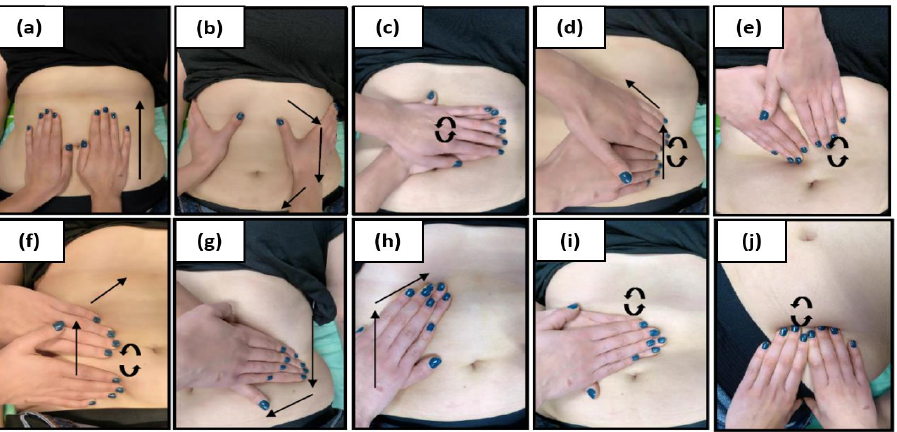
Figure 4. Manual lymphatic drainage of the abdomen; effleurage: during inhalation, rotary technique from the pubic bone to the sternum ( a ); during exhalation, rotary technique from the costal arch and the iliac crest back toward the pubic bone ( b ); circles over the cisterna chili and the course of the large intestine ( c ); stationary circles over the descending ( d ), ascending ( e ) and transverse colon ( f ) withthe pressure applied in the direction of the cisterna chili; stroke of seven: circular strokes over the descending colon from the spleen area to the bladder ( g ); circular strokes over the ascending colon to the liver area ( h ); stationary circles over the naval and return to the spleen area ( i );therapy of the iliac lymph nodes ( j ).